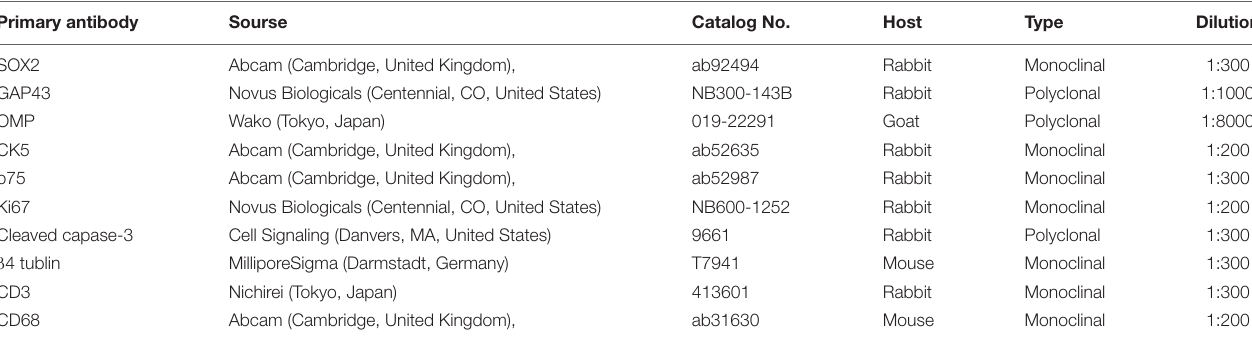
TABLE 1 | Information regarding the primary antibodies used in this study. Primary antibody Sourse Catalog